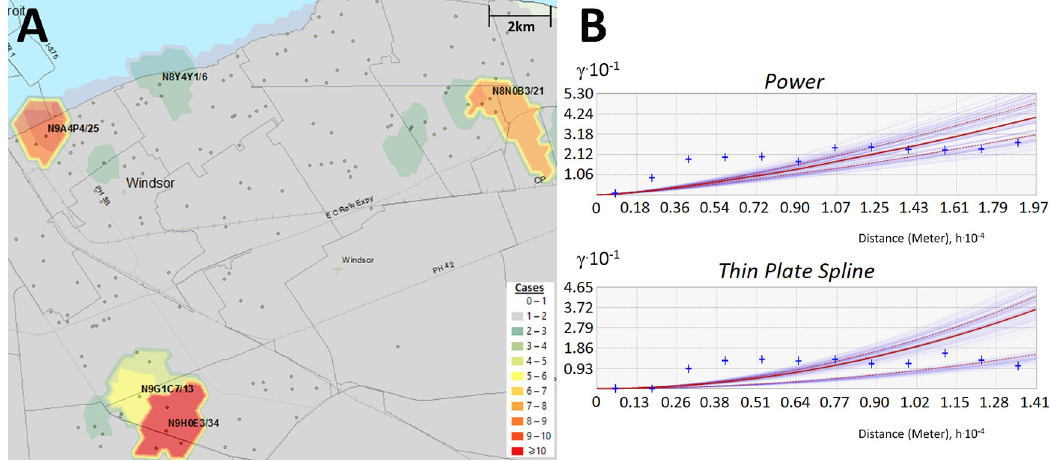
Figure3.InterpolatingthedistributionofCOVID-19casesbyEmpiricalBayesianKriging. Krigingestimatescase counts by interpolating unsampled regions between counts at known locations. Panels indicate: (A) Topographic contours were generated by Empirical Bayesian kriging (EBK) when analyzing PC-level case data in Windsor (Dec. 18 to 20, 2020) and interpolate different case levels within the region; (B) EBK uses empirical semivariograms which describe the correlations between the distance separating a pair of locations with COVID-19-positive individuals, ‘ h ’ , and their corresponding semivariance ‘ γ ’ . Larger values of γ indicate lower spatial autocorrelation between numbers of cases. A semivariogram model fits a curve through γ vs. distance that predicts γ at unsampled locations between known data points. The ‘ Power ’ semivariogram (B, top) is a parabolic mathematical model based on distance, while the Thin Plate Spline semivariogram (B, bottom) is a non-rigid model that passes exactly through bins of paired locations (grouped by distance and direction; blue crosses) while minimizing surface curvature. Red lines represent the median of the distribution of semivariogram